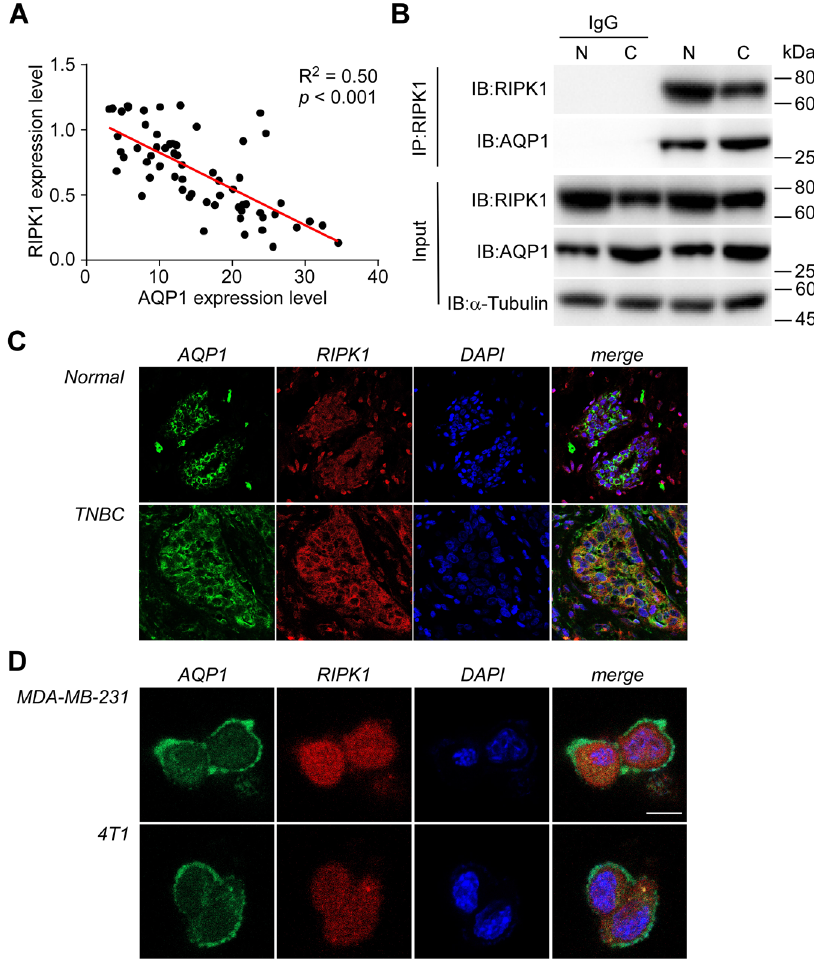
Fig. 3 AQP1 binds with RIPK1 in TNBC. A Linear regression graph. Strong negative correlation ( R 2 = 0.50, p < 0.001) was revealed in TNBC between the abundance of AQP1 and RIPK1 detected by Western blotting. B Co-immunoprecipitation of RIPK1 from TNBC and normal breast tissue showing AQP1 binds with RIPK1. Abbreviations : N, normal breast tissue; C, TNBC. C Representative images of anti-AQP1 (green) and anti- RIPK1 (red) immuno fl uorescence staining of TNBC and normal breast tissue (×400 magni fi cation). Orange/yellow fl uorescence in the merged images represents the colocalization of AQP1 and RIPK1. D Representative images of anti-AQP1 (green) and anti-RIPK1 (red) immuno fl uorescence staining of MDA-MB-231 and 4T1 cells stably overexpressing AQP1 and RIPK1. Orange/yellow fl uorescence in the merged images represents the colocalization of AQP1 and RIPK1. Scale bar : 20 μ